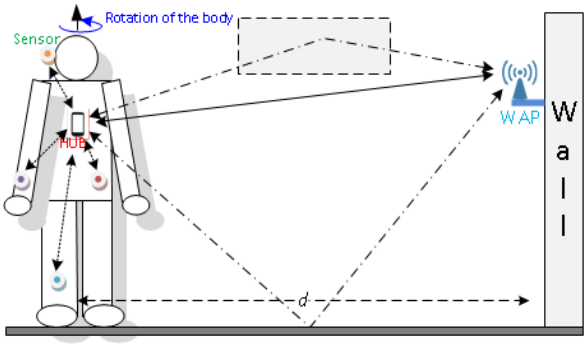
Figure 1. Adaptive WBAN Scenario [7]